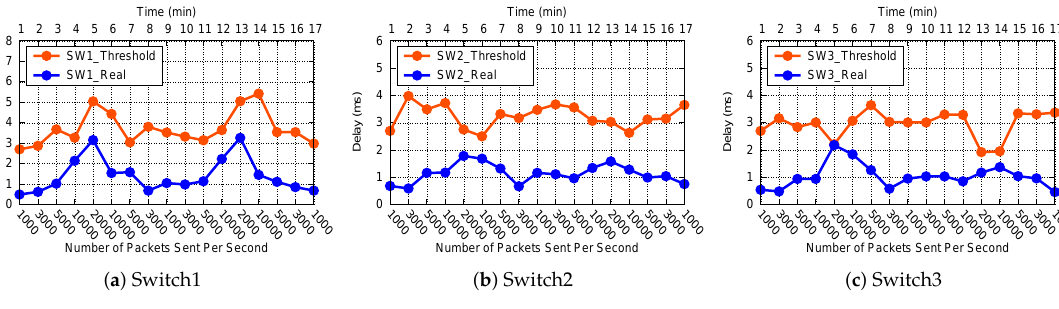
Figure 8. Delay threshold and real delay comparison.